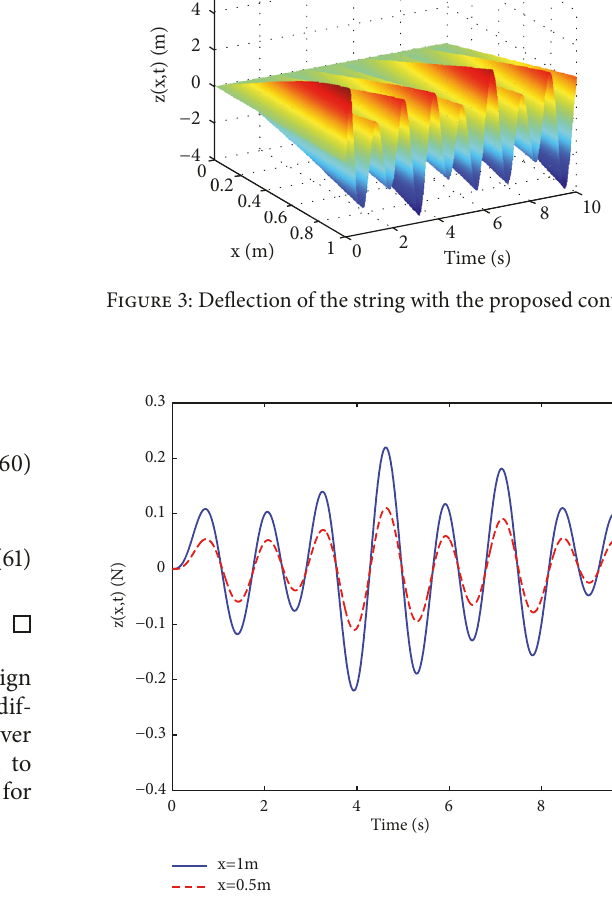
Figure 4: Two-dimensional deflection of the string without control.